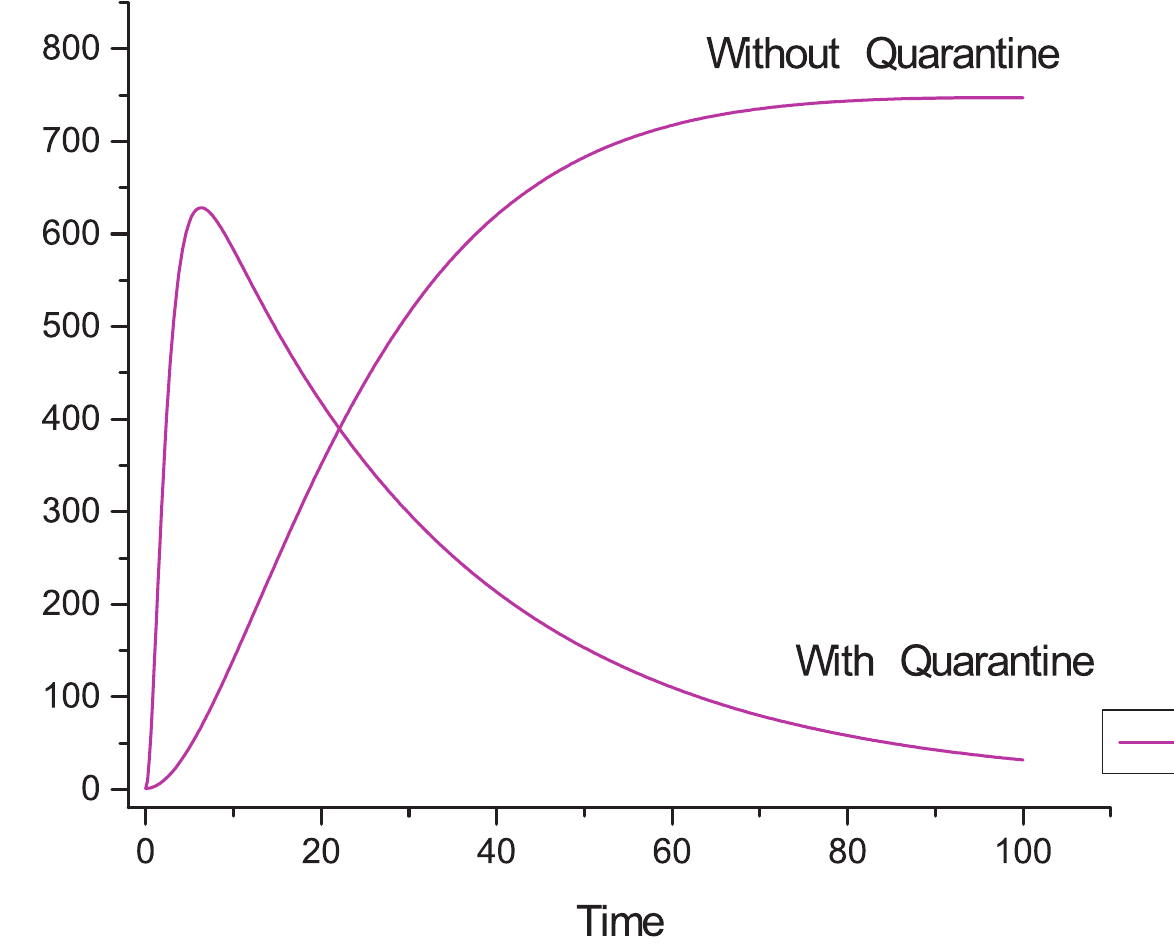
Fig 10. Dynamic behaviour of infectious class with and without